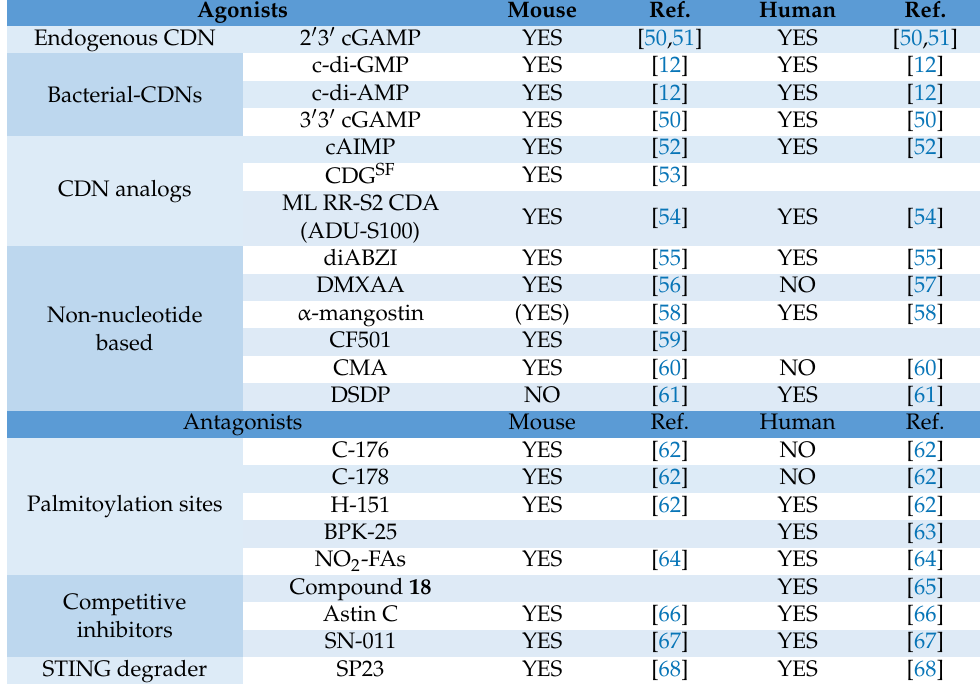
Table 1. Species specificities of the STING agonists/antagonists. Agonists Mouse Ref. Human Ref. Endogenous